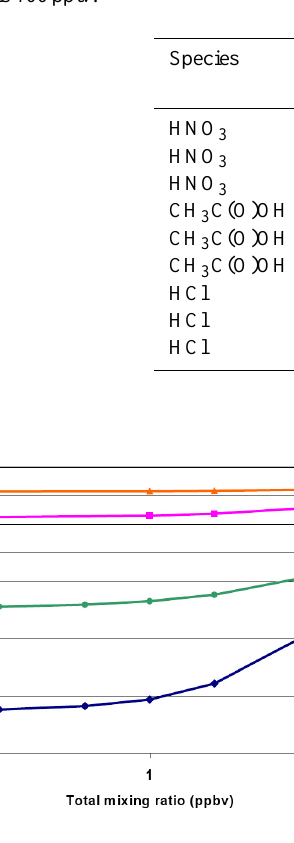
Table 3. Impact of the number of hexagonal columns which compose an aggregate ice particle on the mean and the minimum gas phase mixing ratios of HNO 3 , CH 3 COOH and HCl along the 7 trajectories of the REF simulation. The total mixing ratio (gas+surface) for the three species is 100pptv.